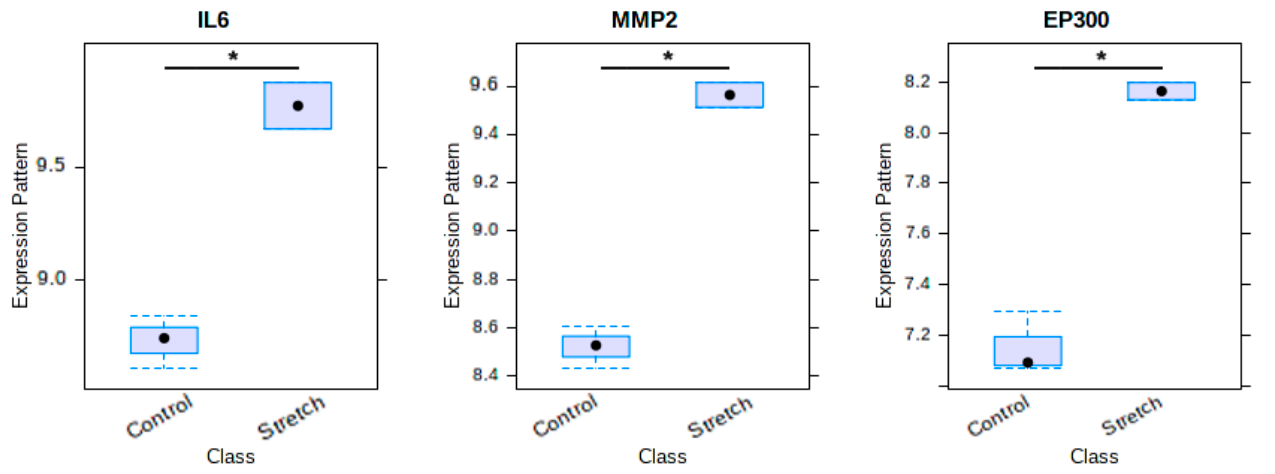
Figure 8. Expression patterns of identified genes associated with distraction osteogenesis between distraction group and control group. * p < 0.05.